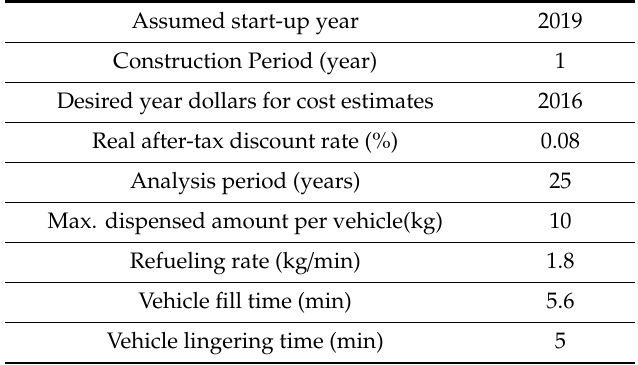
Table 3. General assumption for the heavy-duty refueling station analysis (HDRSAM)